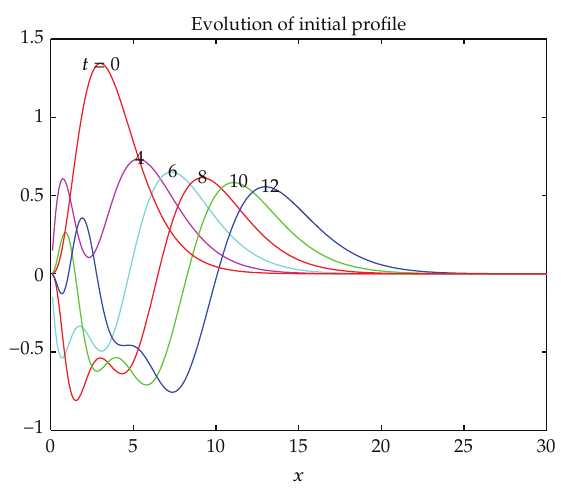
Figure 10: Example 5.2: by infinite system.